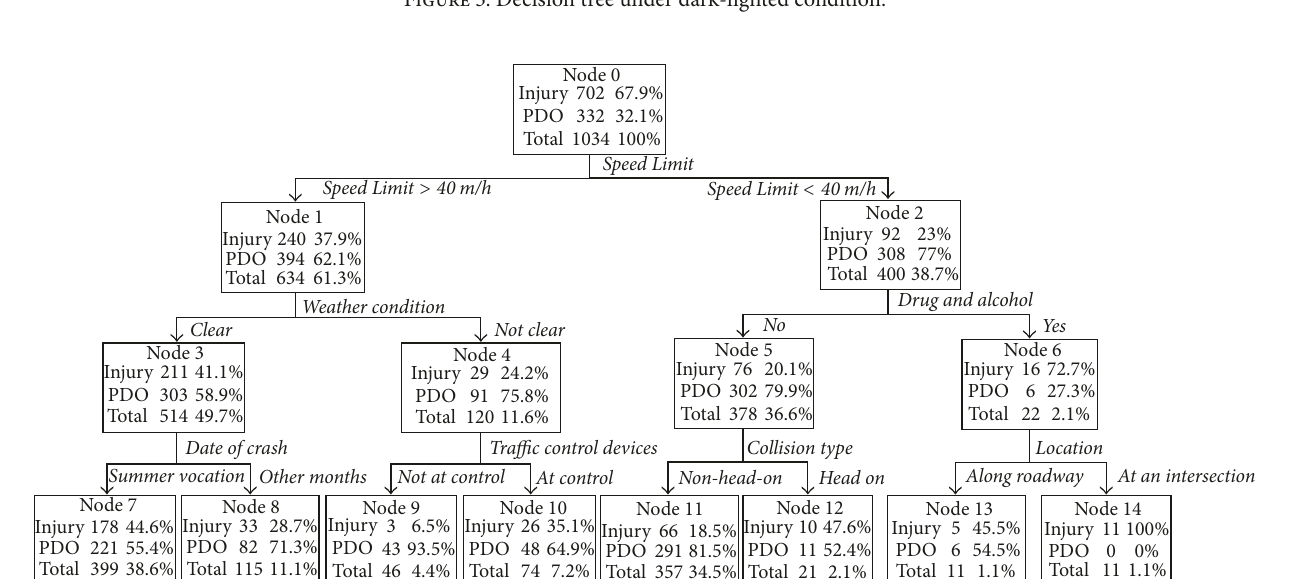
Figure 4: Classification tree under dark-not-lighted